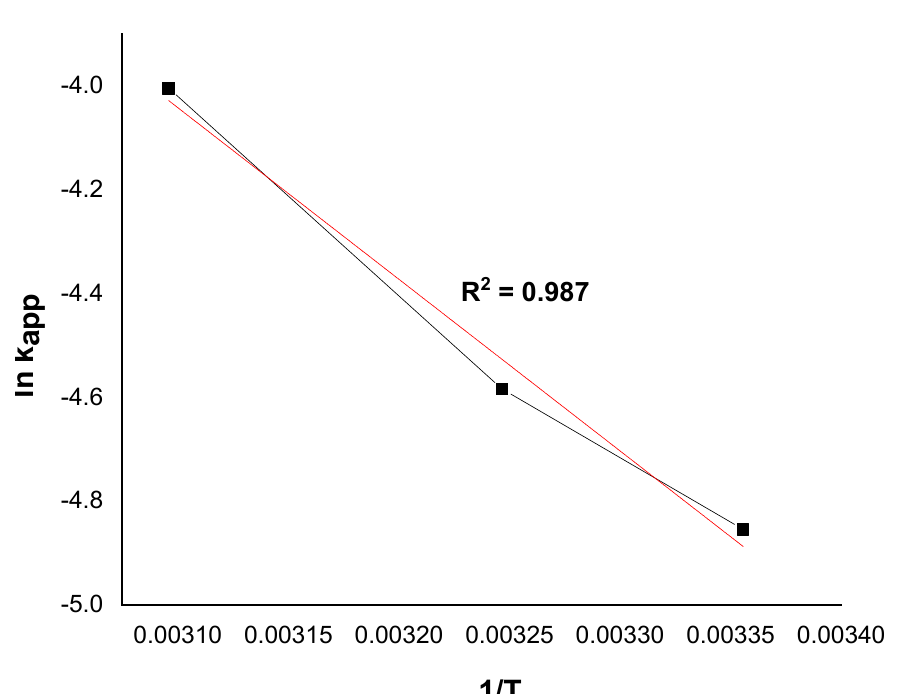
Figure 10. The plot of ln k app versus 1/ T at different temperatures. The apparent activation energy of the catalytic oxidation of the dye is 27.51 kJ/mol.